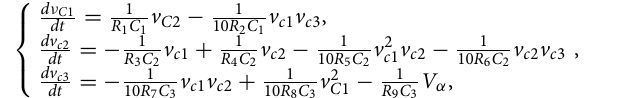
y ( 0 ) plane with z ( 0 ) − 0.1 =